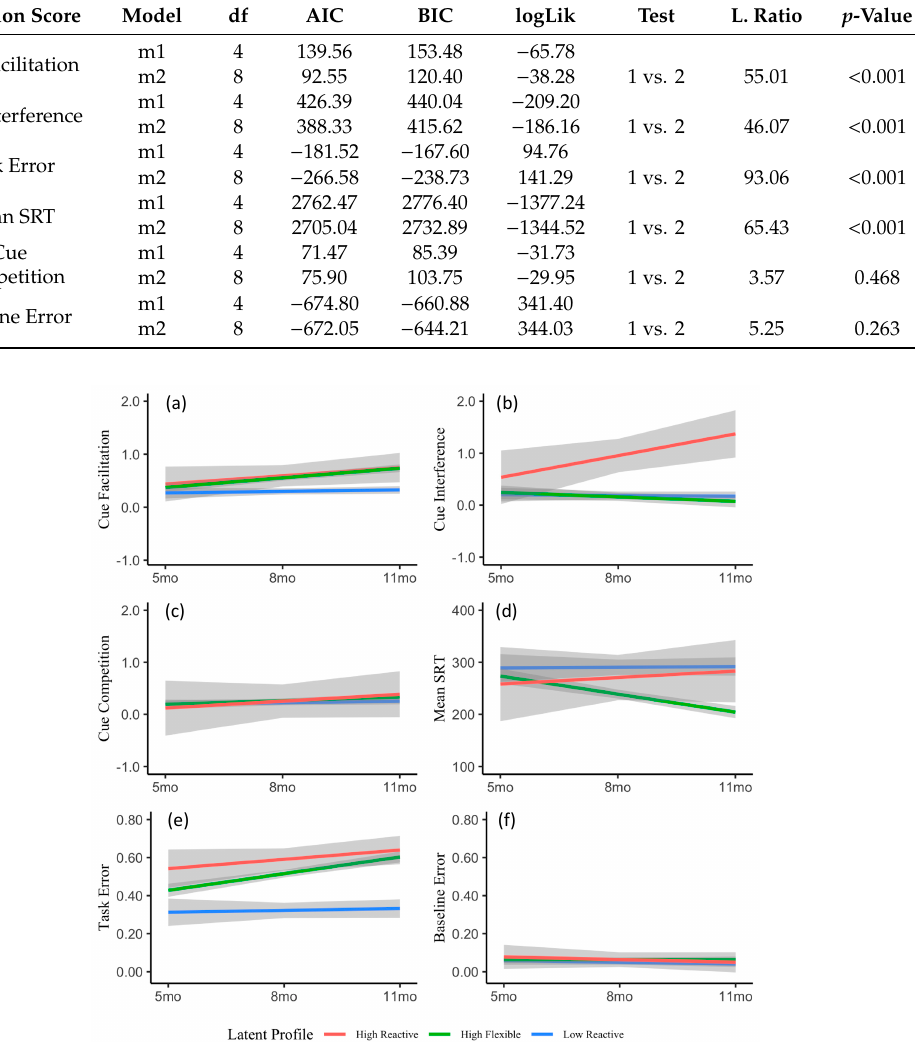
Table 4. Comparison of time-only baseline model (m1) versus model containing main effects and time interactions for the latent profiles (m2).